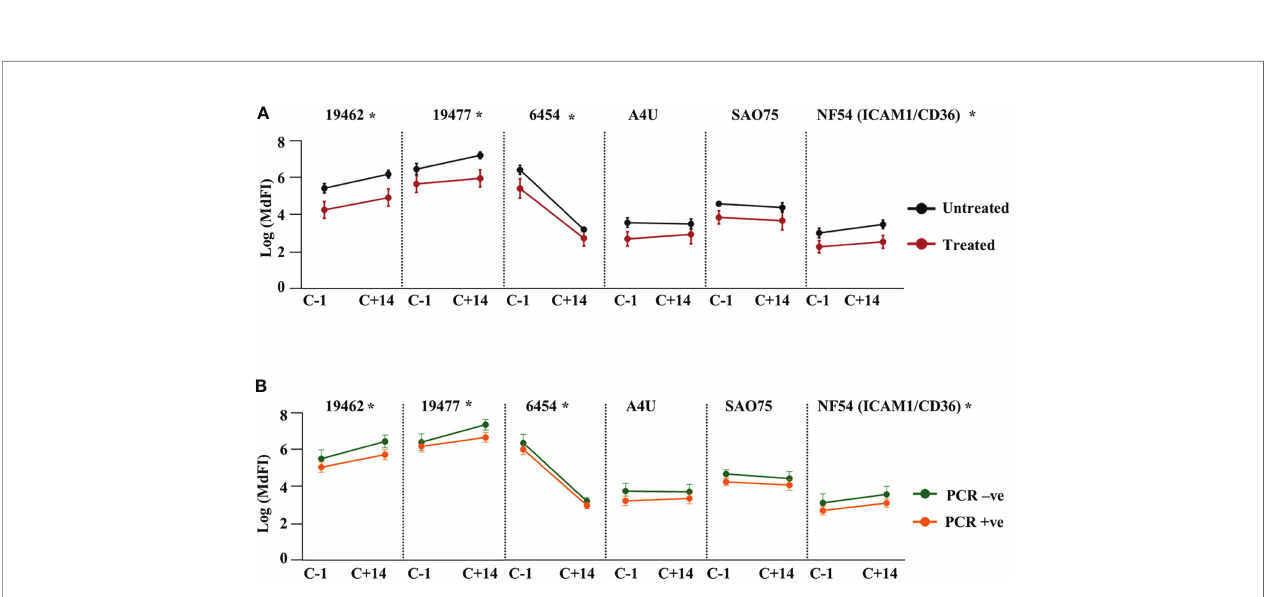
FIGURE 3 | Change in heterologous anti-VSA antibodies levels after the challenge. Anti-VSA antibodies to the test isolates a day before and on day 14 after the challenge strati fi ed by: (A) treatment outcome and (B) parasitaemia (*-